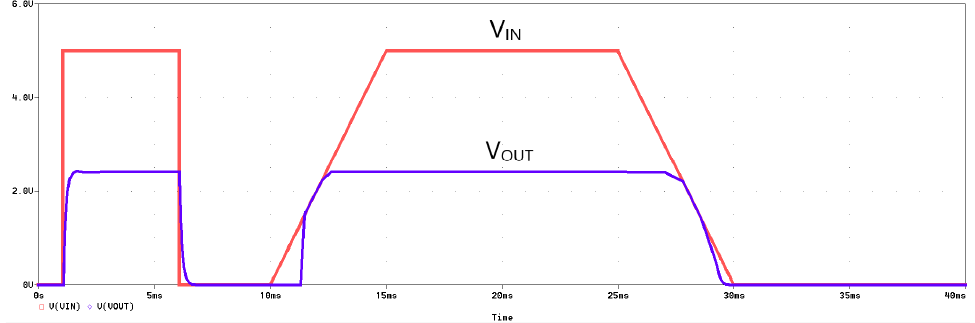
Figure 6. Simulation results for the demo application circuit of TPS785-Q1.